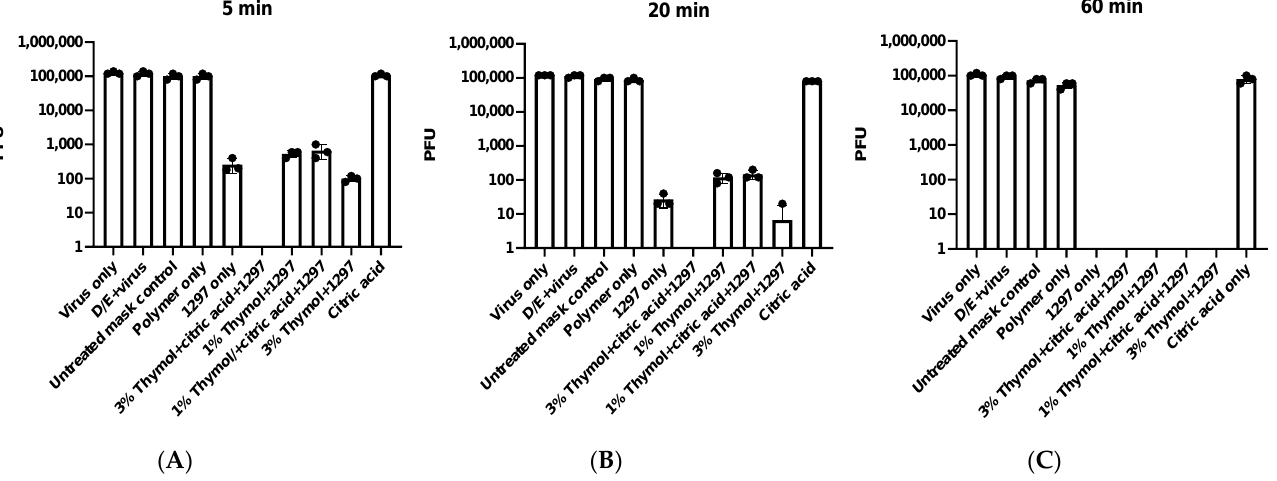
Figure 2. Rapid inactivation of SARS-CoV-2 by quaternary ammonium salt-infused masks. ( A – C ) n = 3, shown is representative from 2 separate